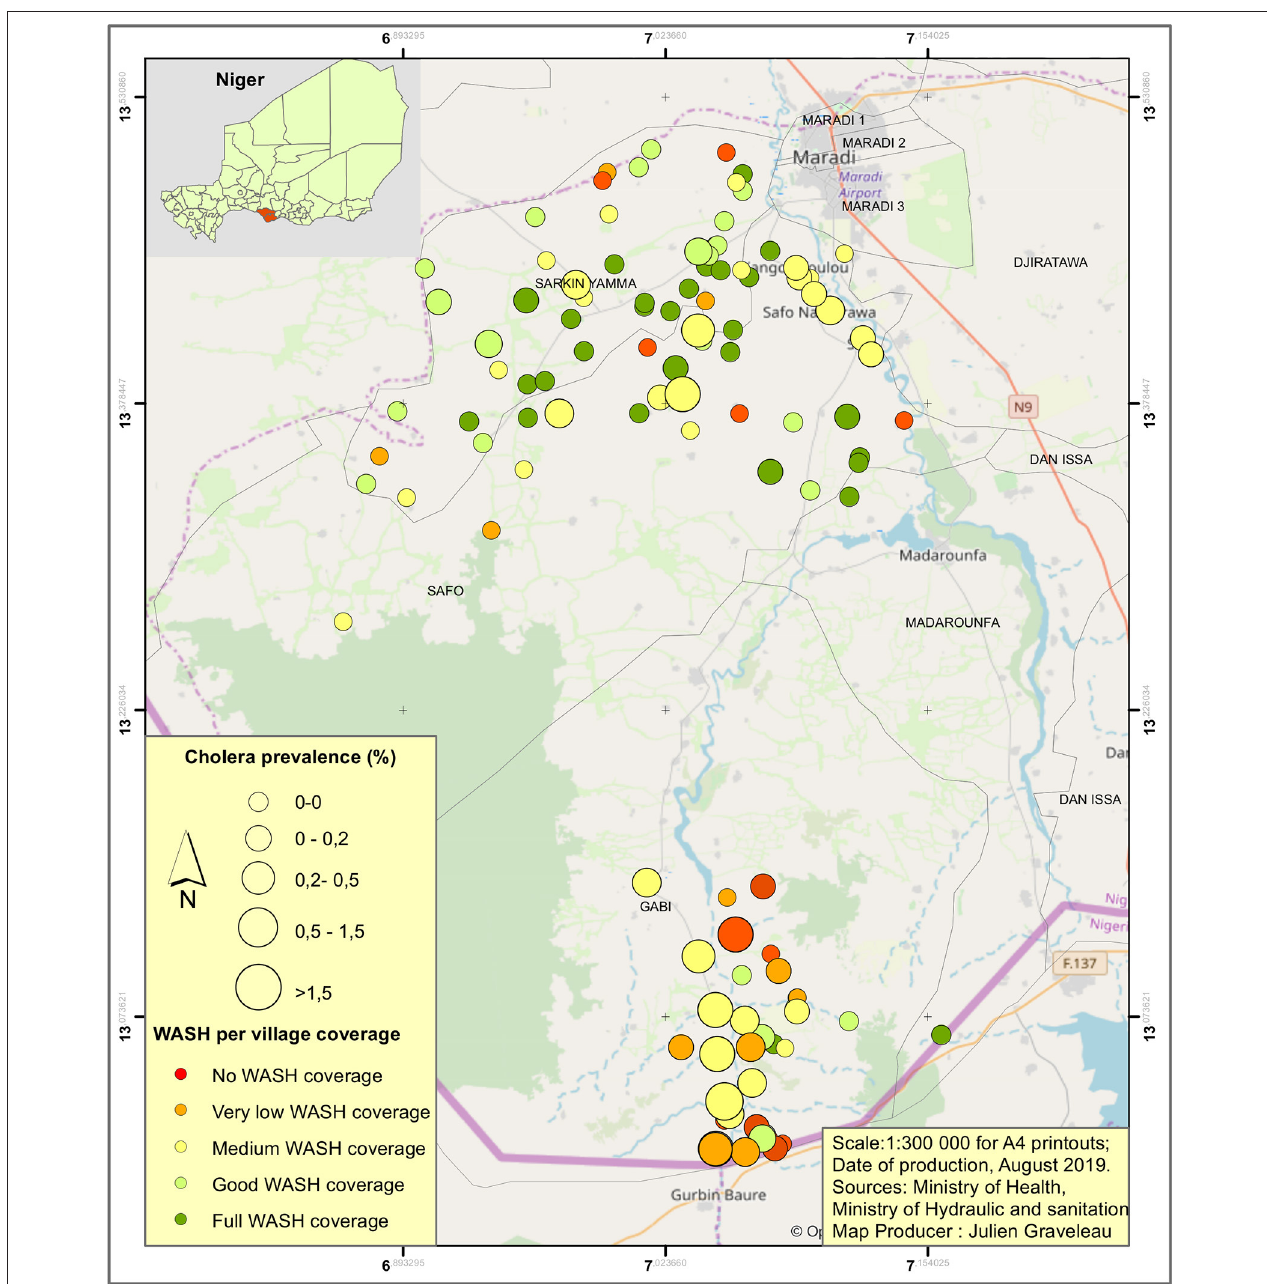
FIGURE 1 | Map of the prevalence of cholera in the studied villages during the 2018 cholera outbreak regarding the Water, Sanitation, and Hygiene (WASH)